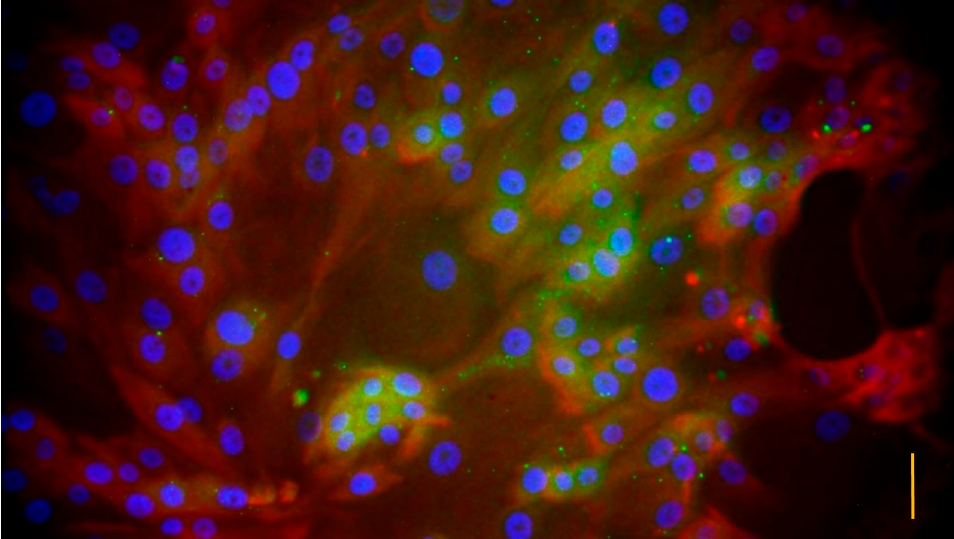
Figure 4. Immunofluorescent staining of uroepithelial cell culture on day 6 after plating. Blue color indicates diamidino phenylindole (DAPI) labeled cell nuclei, red color shows epithelial cells detected with eFluor labeled pan-cytokeratin antibody, and green color refers to differentiated uroepithelial cells stained with fluorescein isothiocyanate (FITC) labeled uroplakin III antibody. (bar = 3.5 µm) .